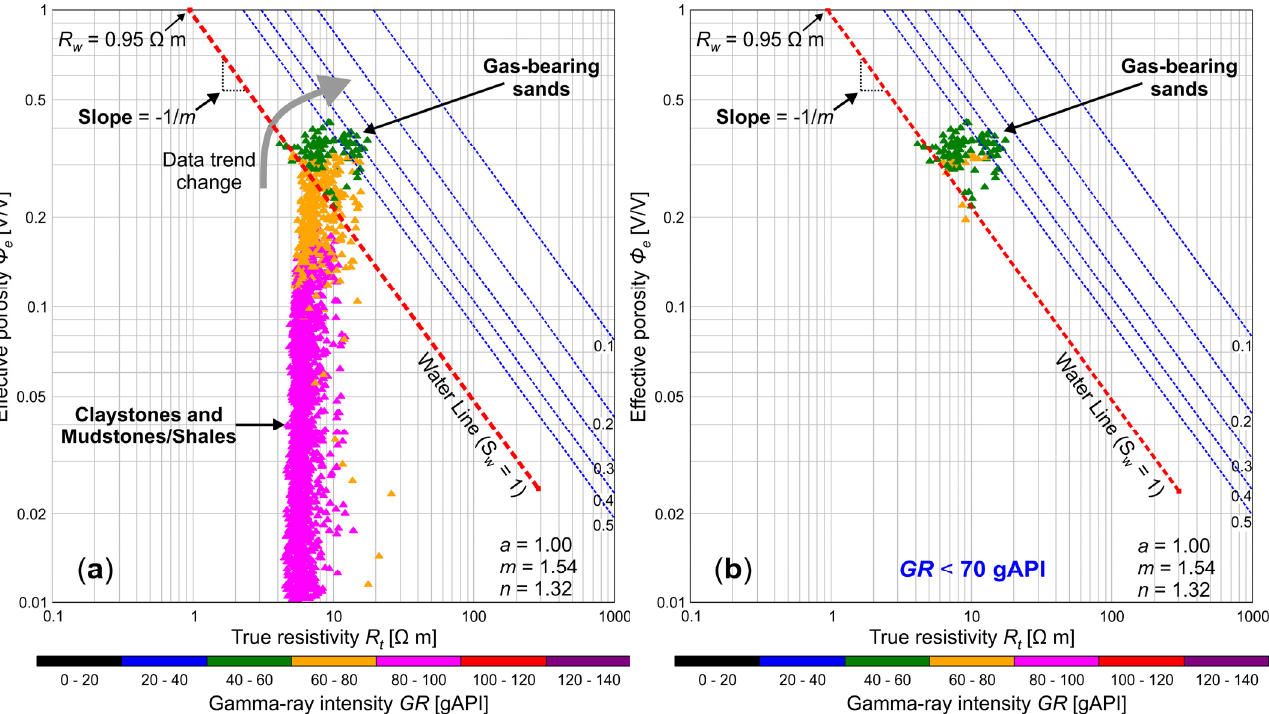
Figure 11. Pickett-type resistivity–porosity crossplots based on the effective porosity ( φ e ) resulted from well log interpreta- tion and parameters ( ρ ma , m , n ) obtained from core analyses (RCAL and SCAL). ( a ) B-3 well (2080 data levels); ( b ) B-3 well with a gamma-ray cut-off applied ( GR < 70 gAPI) (113 data